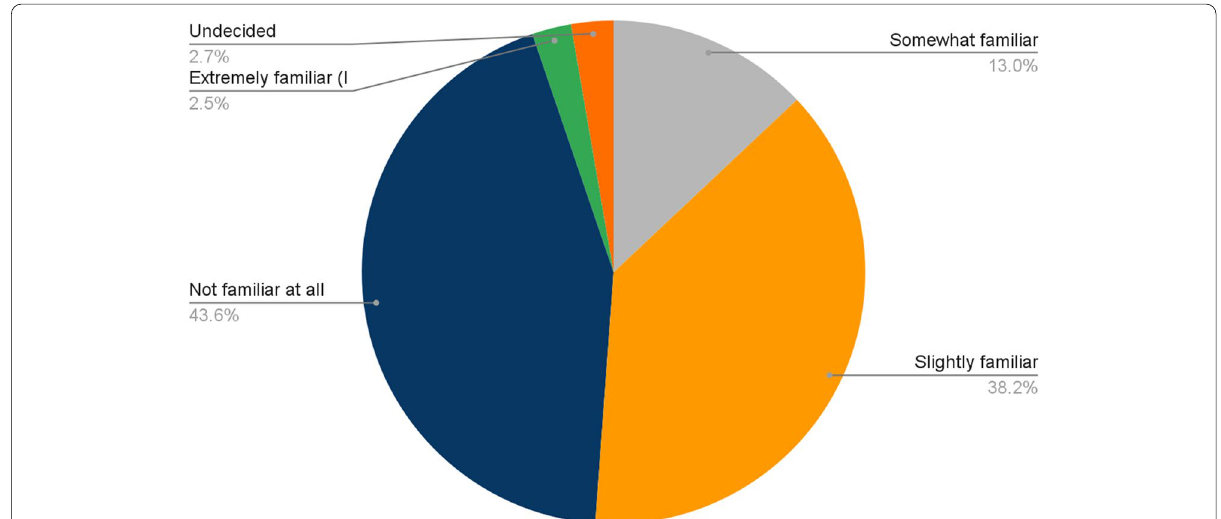
Fig. 1 Level of familiarity with blockchain technology among general population. Note . Majority of respondents are not familiar or only slightly familiar with blockchain technology. N 517 =